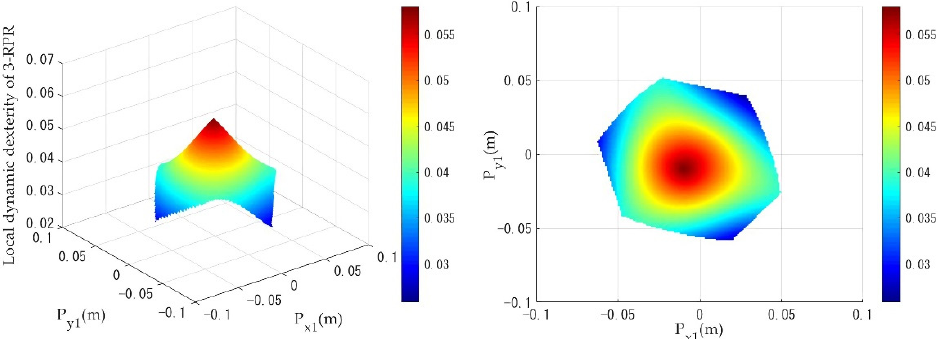
Figure 14. Distribution of the local dynamic dexterity of the 3-RPR PPM under a linear trajectory.